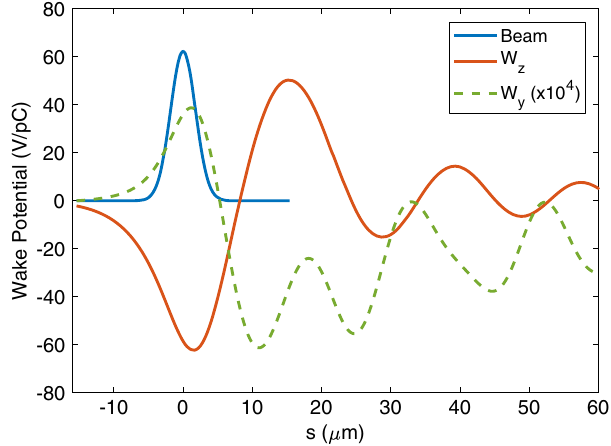
FIG. 12. Longitudinal (red curve) and transverse (green curve) wake potentials induced into the collimator by the witness bunch (blue curve). To represent the lines with the same axis scale, the transverse wake W (calculated at distance r ¼ 50 μ m from the y collimator axis) has been enhanced by a factor of 10 4